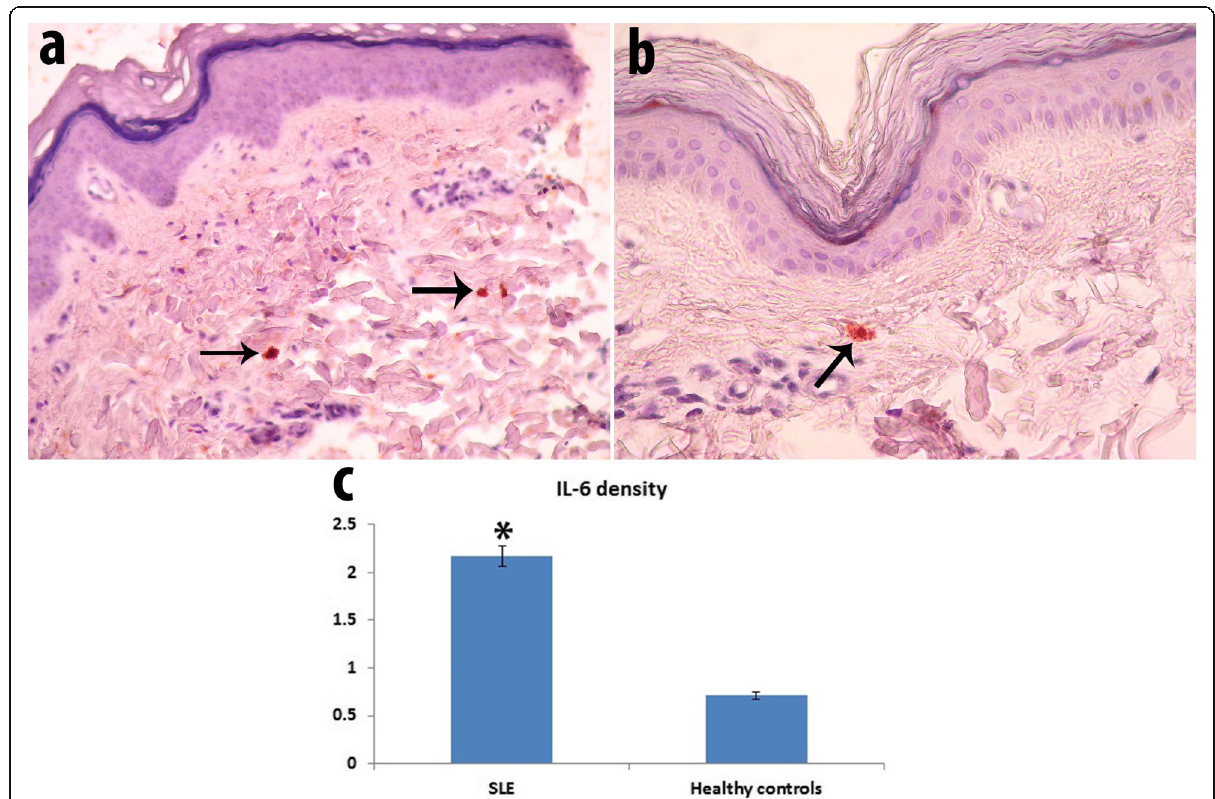
Fig. 2 IL-6 density in SLE patients and controls. a SLE, b Controls, c Bar